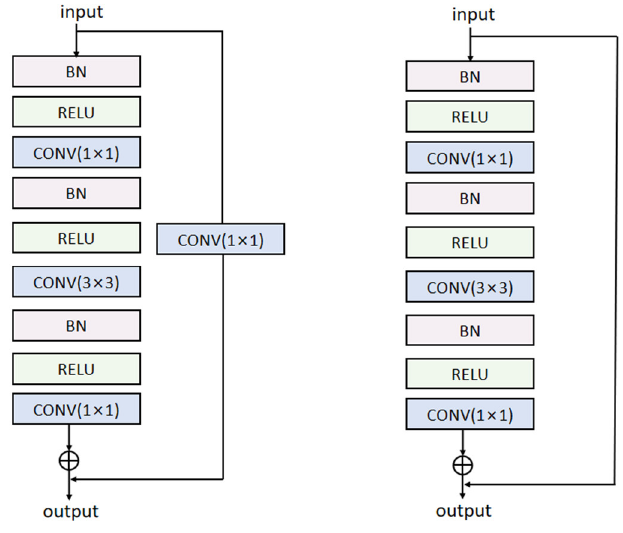
Figure 2. The structure of the residual module.